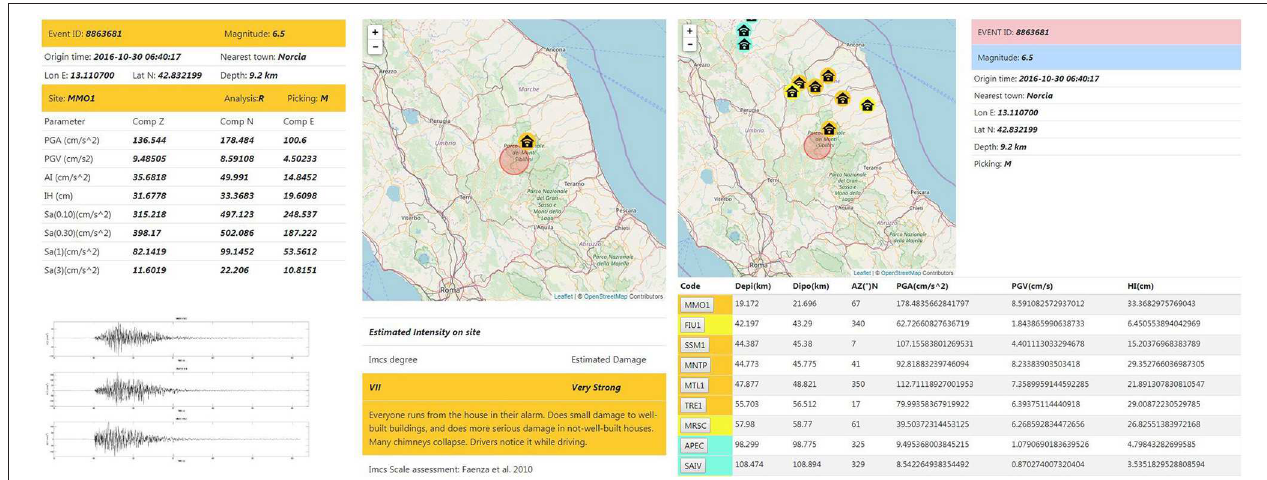
FIGURE 6 | Example of results after a seismic event, available for regional civil protection. Left: event panel of the SPB seismic stations that recorded seismic event. Right: event-station panel and strong motion parameters recorded at a single station. The color scale represents macroseismic intensity Imcs (light blue: V; yellow: VI; orange: VII) estimated by Faenza and Michelini (2010).